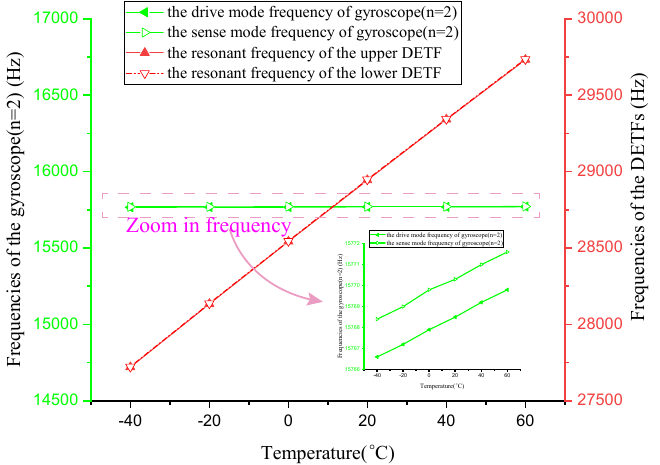
Figure 11. The working frequencies of the DETFs and the ring gyroscope at different temperatures.